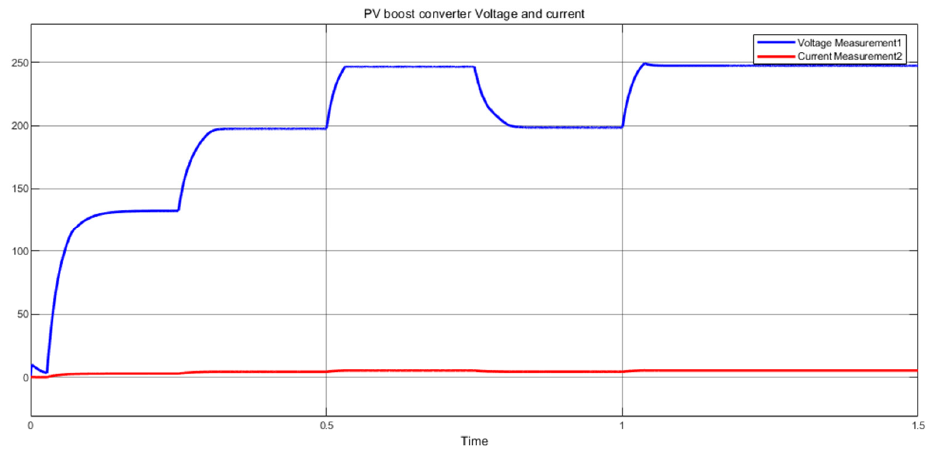
Figure 6. Output voltage/current of the converter.